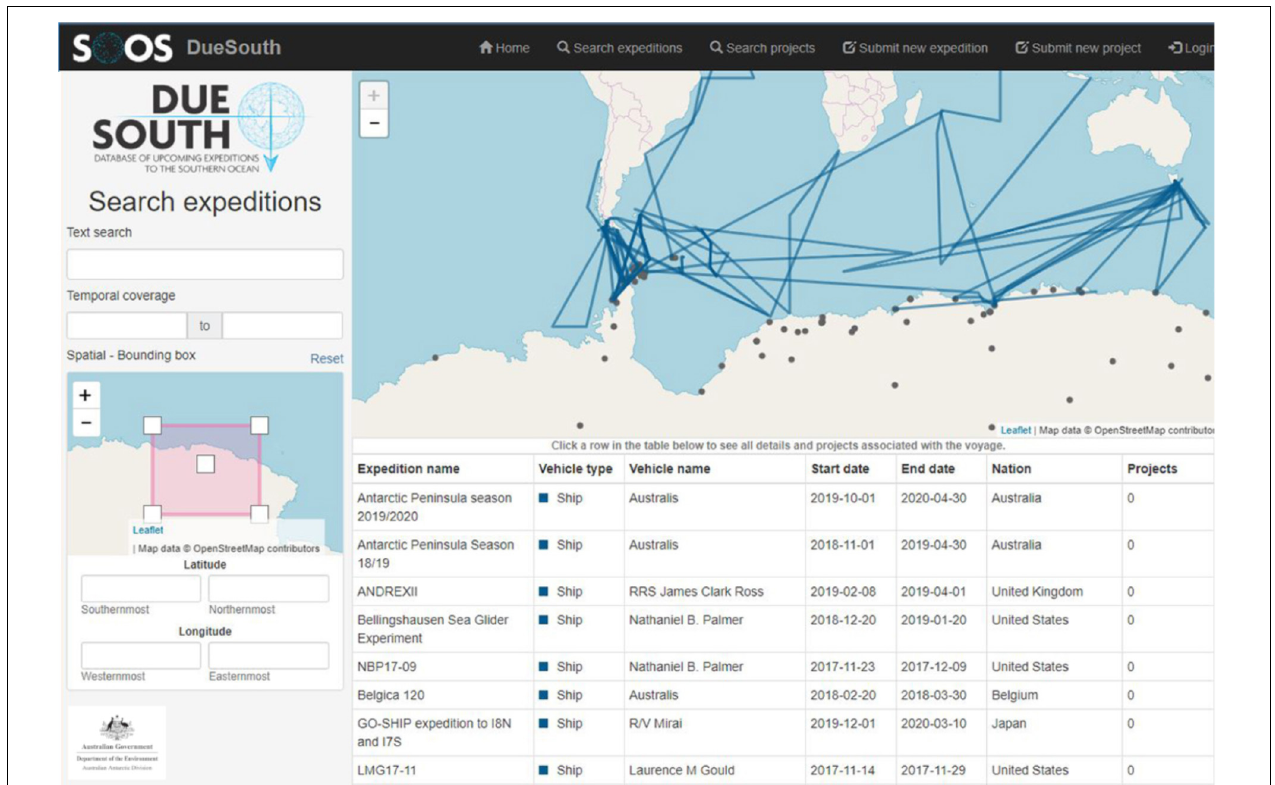
FIGURE 4 | DueSouth is the Database of Upcoming Expeditions to the Southern Ocean and is a coordination tool that enables users to find out which expeditions (e.g., voyages, flights, traverses) are planned for future field seasons, and what observational projects are funded to take place on each expedition. It is developed and maintained for SOOS by the Australian Antarctic Data